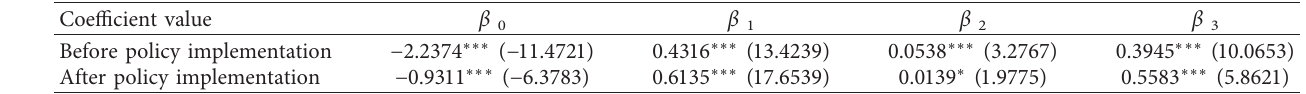
Figure 5: Relationship between ln (RCSDI) and ln (V) after the policy. Table 4: Empirical test results before and after the implementation of the